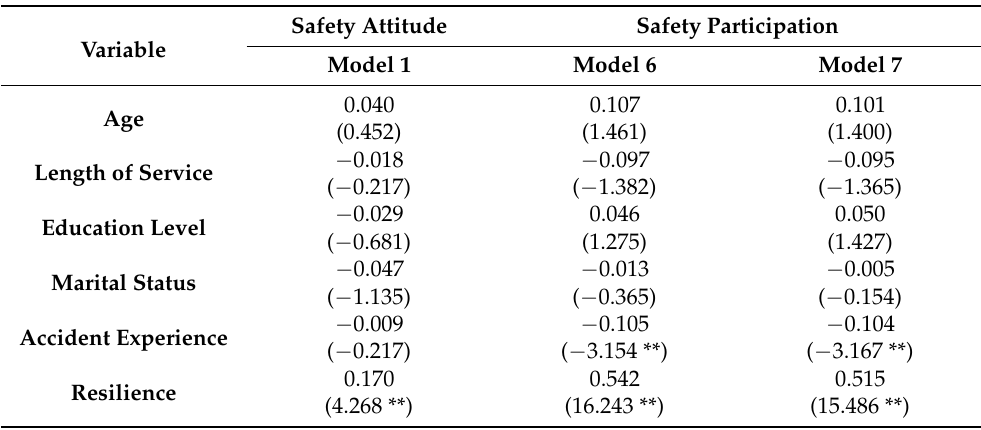
Table 18. Hierarchical regression of the mediating role of safety attitude between coal miners’ resilience and safety participation (N =